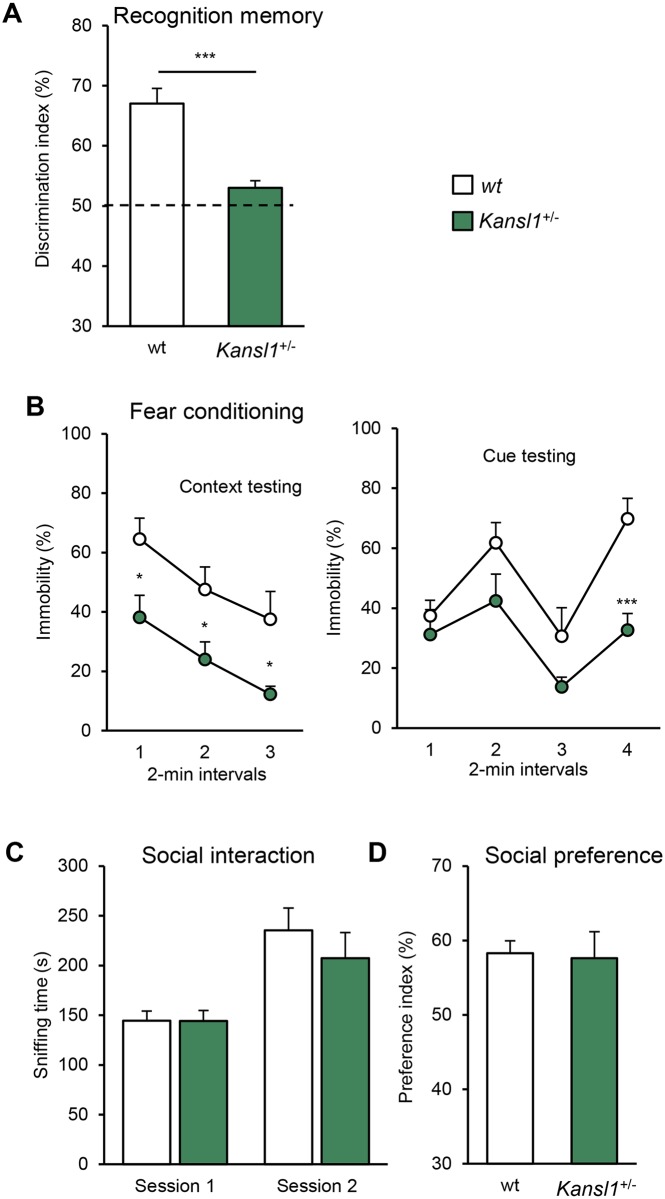
Learning and memory phenotypes in the Kansl1+/-.(A) Novel object recognition test. Discrimination index was calculated as the ratio of time spent exploring the novel object vs the familiar object in the choice trial after a 3 h retention delay. (B) Fear conditioning test. Plots represent the fraction of time spent freezing during test sessions. As above the 6-min context session was run 24 h after conditioning and the 8-min cue session was performed 5h after the context. A sequence of 2-min with no cue and 2 min with light/auditory conditioning stimulus was repeated two times. (C-D) Three-chamber sociability test. (C) Exploration time (s) of the first congener in the social interest session (session 1) and total exploration time of familiar and novel congeners in the social discrimination session (session 2). No delay was used between the two sessions. (D) Discrimination index was calculated as the ratio of time spent exploring the novel congener vs the familiar one. Data are represented as the mean ± s.e.m.. Cohort used included 8 Kansl1+/- and 10 wt animals. Tukey's and Mann Whitney U tests following a significant one-way ANOVA and Kruskal Wallis analysis, respectively. *P < 0.05 vs wt, **P < 0.01 vs wt, ***P < 0.001 vs wt, #
P < 0.05 vs all other groups.